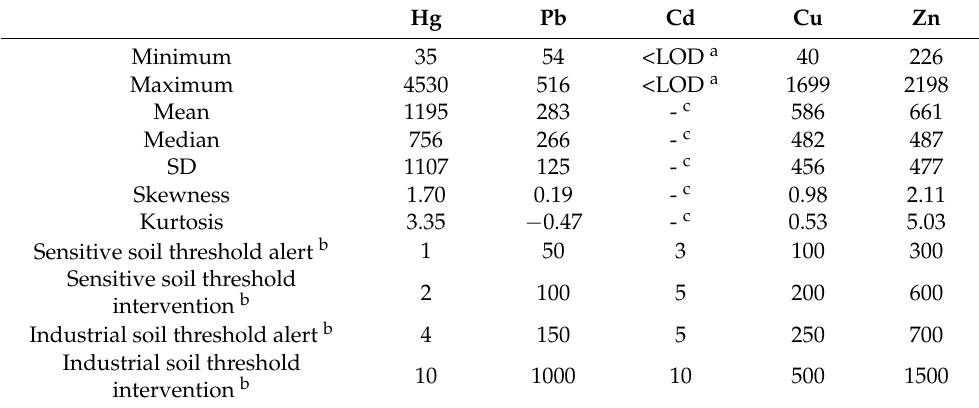
Table 1. Summary statistics of Cd, Cu, Hg, Pb, and Zn (mg/kg) in rhizosphere soil samples by portable X-ray fluorescence (PXRF) spectrometry for polluted soil in Turda, Romania. Hg